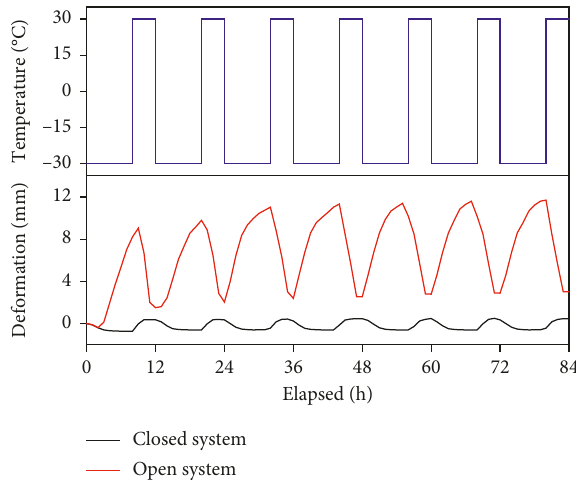
Figure 3: Variations of temperature inside the sample during one freeze-thaw cycle.